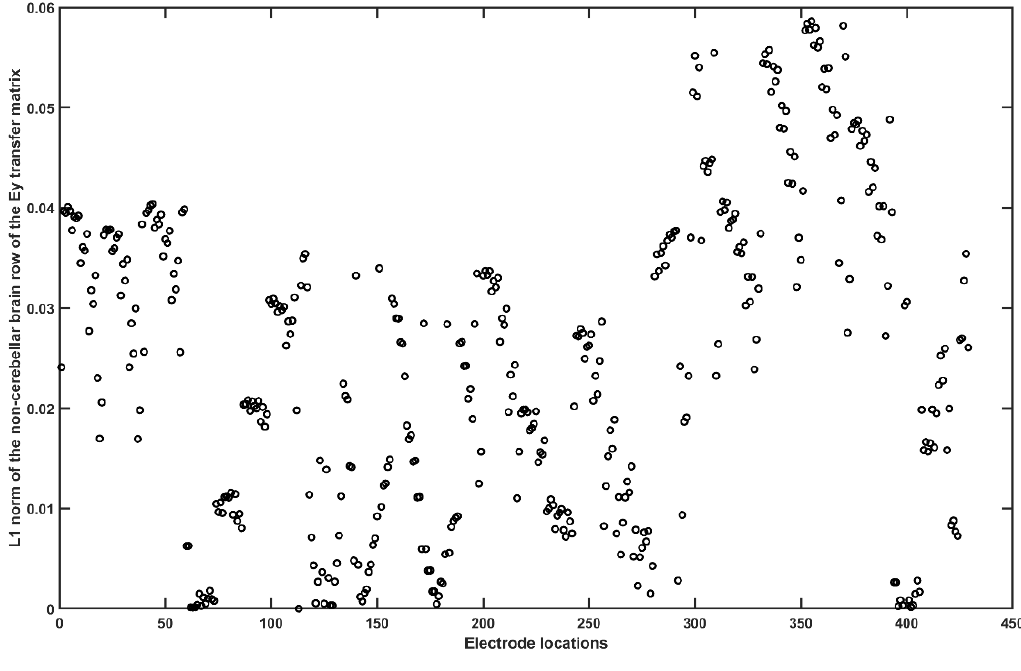
Figure A7 . L1 norm of the non − cerebellar brain row (= 35) of the Ey transfer matrix.